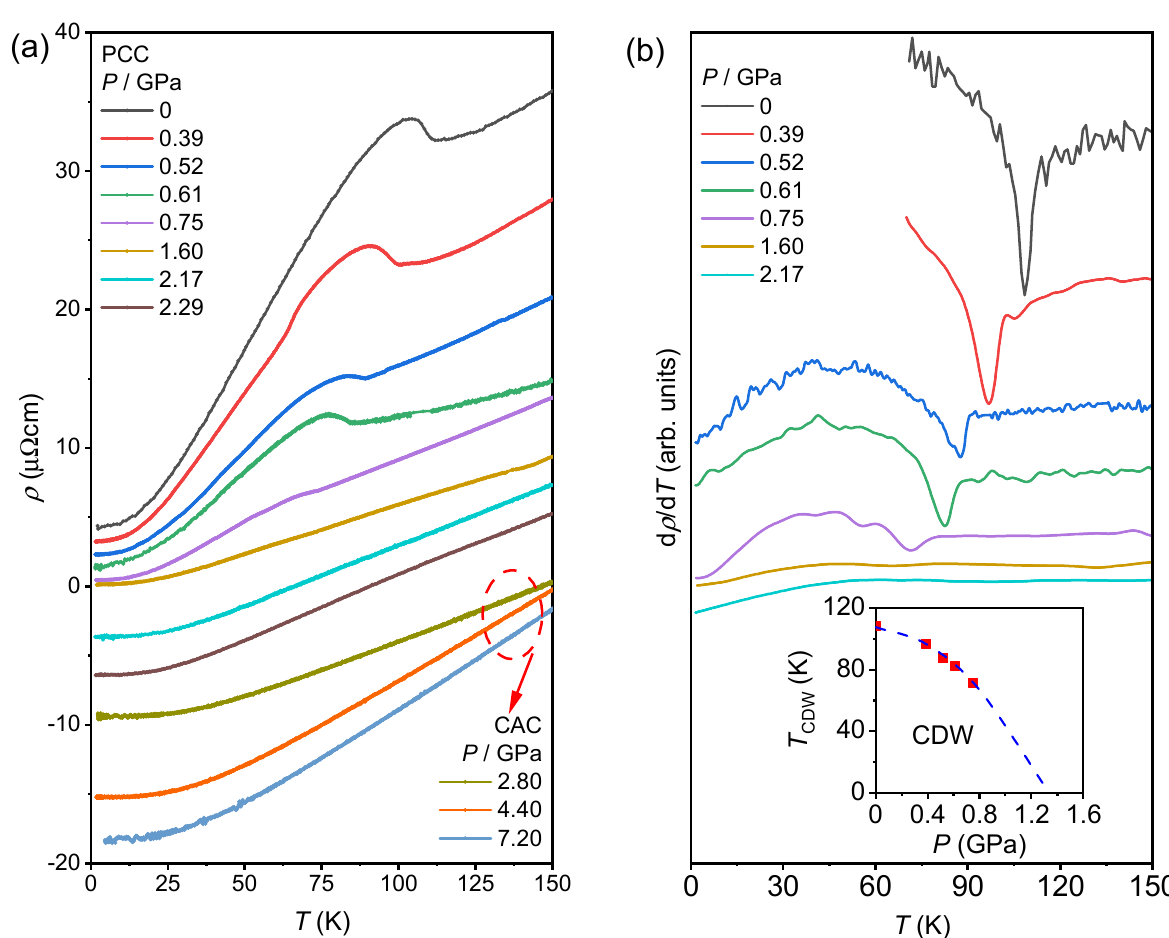
Figure 2. Temperature-dependent ( a ) resistivity ρ ( T ) and ( b ) its derivative d ρ /d T of PdTeI under various hydrostatic pressures up to 7.2 GPa. All the resistivity curves were vertically shifted for clarity. The inset shows the CDW transition temperature T CDW as a function of pressure.